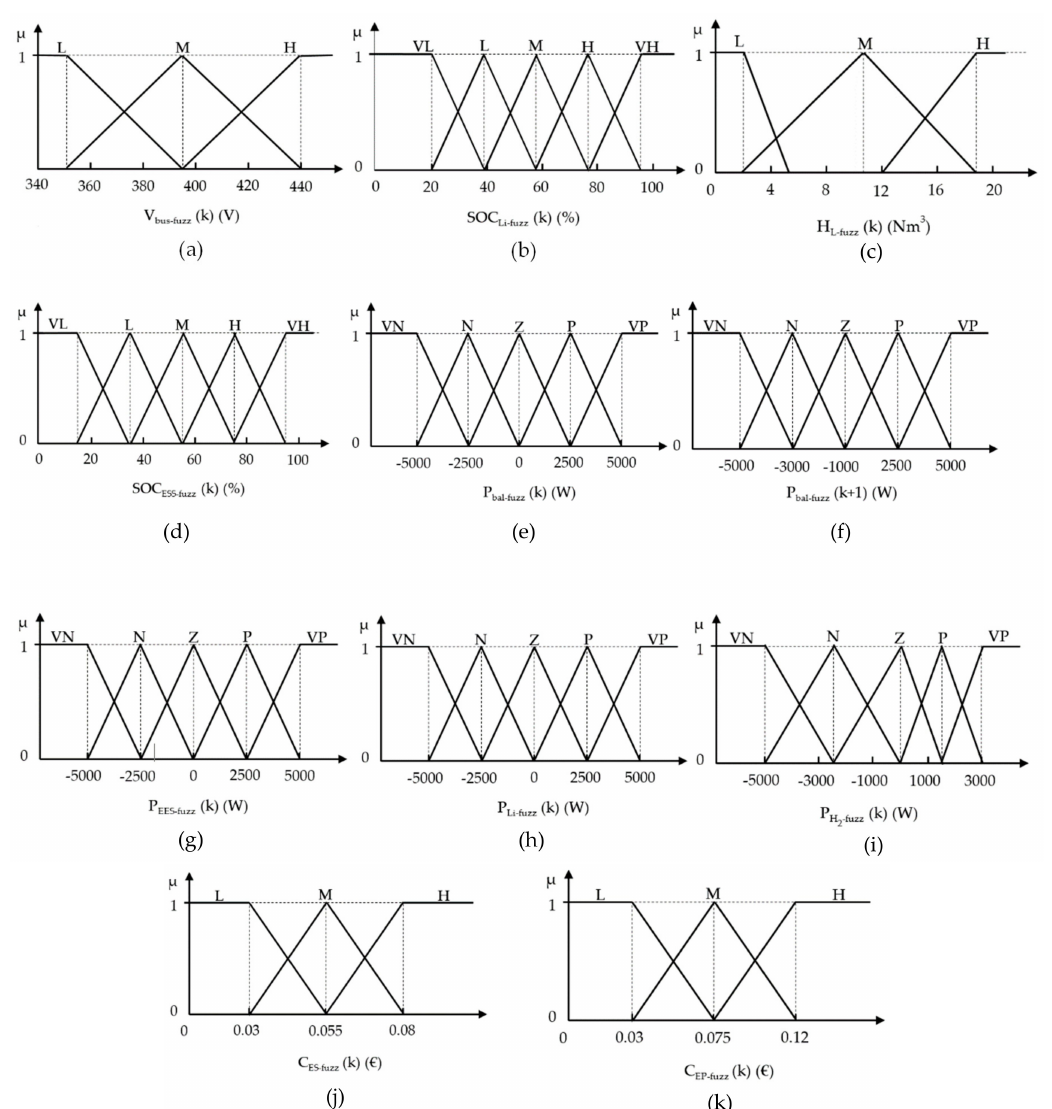
Figure 6. Membership functions of the fuzzy sets for: ( a ) bus voltage, V bus − fuzz ( k ) ; ( b ) Lithium battery state of charge, SOC Li − fuzz ( k ) ; ( c ) hydrogen level, HL − fuzz ( k ) ; ( d ) ESS state of charge, SOC ESS − fuzz ( k ) ; ( e ) Power balance, P bal − fuzz ( k ) ; ( f ) Power balance prediction, P bal − fuzz ( k + 1 ) ; ( g ) ESS power setpoint, P ESS − fuzz ( k ) ; ( h ) Lithium battery power setpoint, P Li − fuzz ( k ) ; ( i ) Hydrogen-based system power setpoint, P H − fuzz ( k ) ; ( j ) Grid selling cost, C ES − fuzz ( k ) ; ( k ) Grid purchase cost, C EP − fuzz ( k ) 2